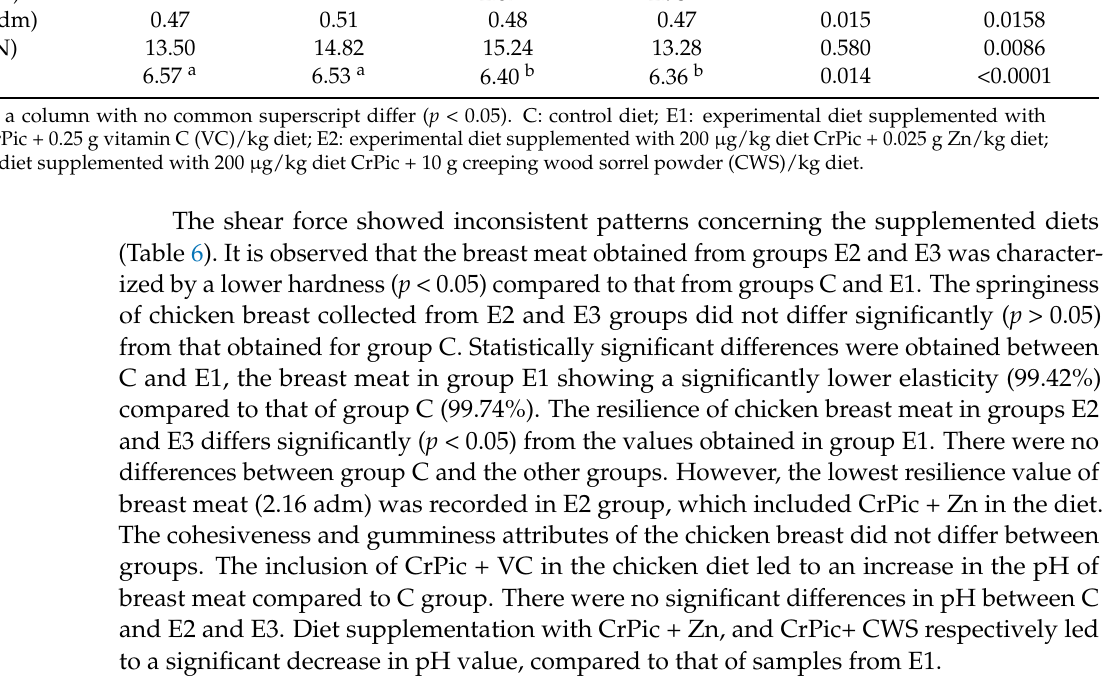
Table 6. Texture parameters of breast